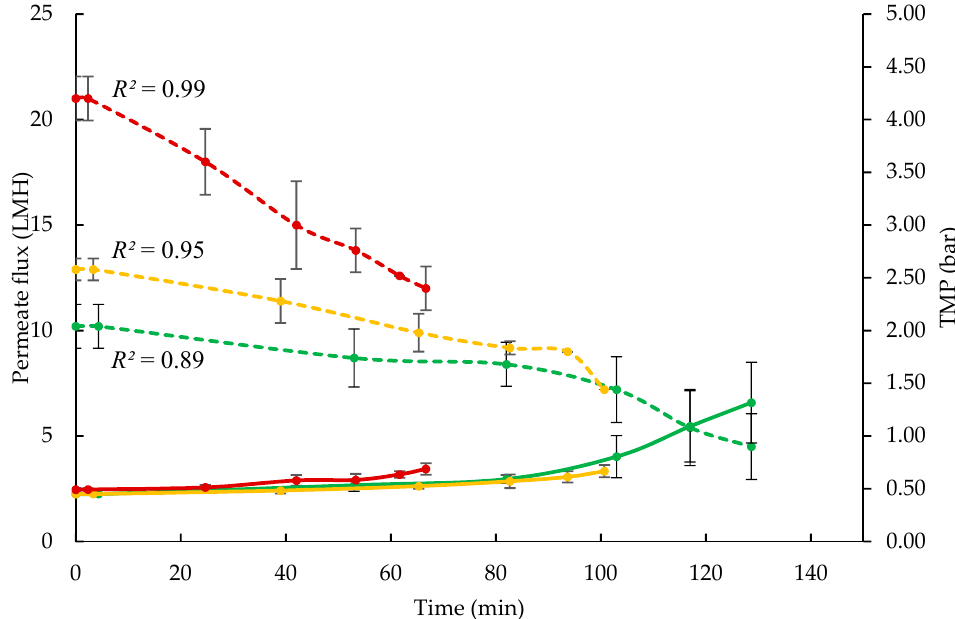
Figure 2. Permeate flux and transmembrane pressure (TMP) as a function of processing time during ultrafiltration of skim milk with 10 kDa membrane at 5 ± 0.5, 20 ± 0.5, and 50 ± 0.5 °C. Line colour represents flux at 5 °C ( ▪▪▪ ), 20 °C ( ▪▪▪ ), 50 °C ( ▪▪▪ ); TMP at 5 °C ( ▬ ), at 20 °C ( ▬ ), at 50 °C ( ▬ ). Values are raw mean ± standard deviation of data from triplicate runs at each test temperature. LMH: L/m 2 /h.